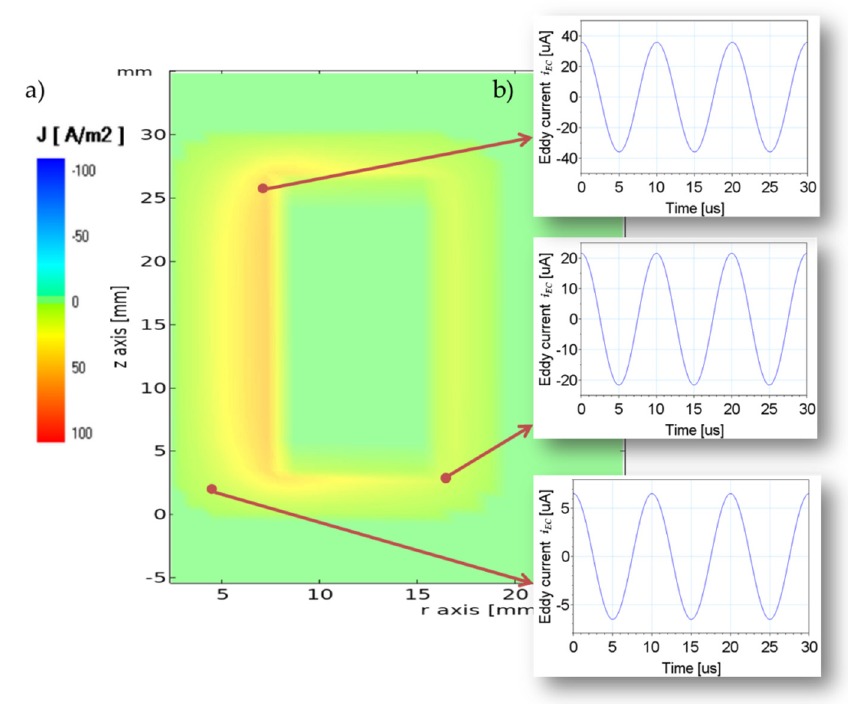
Figure 13. Distribution of the eddy current density in the ferrite core for time t = 10 us ( a ) and the waveforms of the eddy currents i EC for three selected points of ferrite core ( b ) for a frequency of 100 kHz.